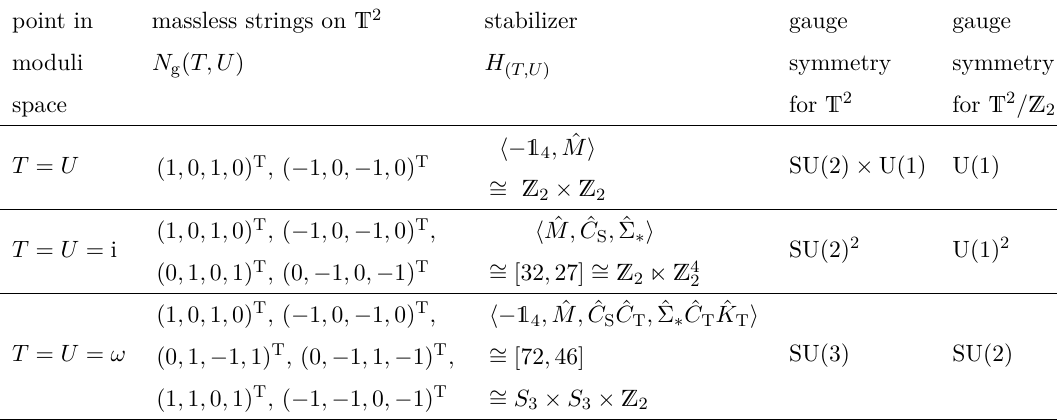
Table 3. Gauge symmetry enhancements of the T 2 / Z 2 orbifold sector at special points in moduli space. We use ω := e 2 π i / 3